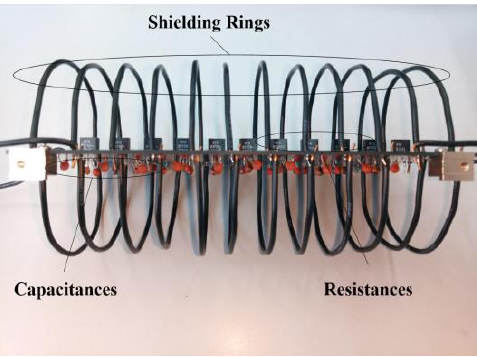
Figure 2. Structure of the resistive voltage divider compensated for by capacitances and shielding rings.